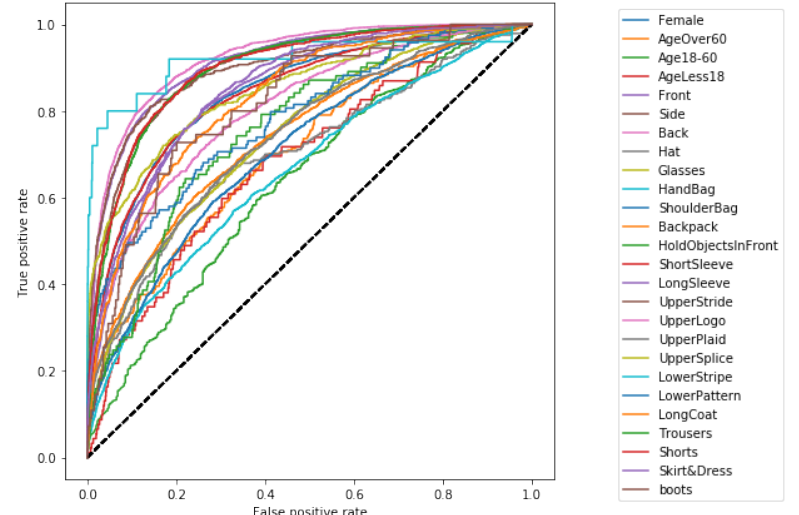
Figure 15. ROC curve of Model 5 on the PARSE100K